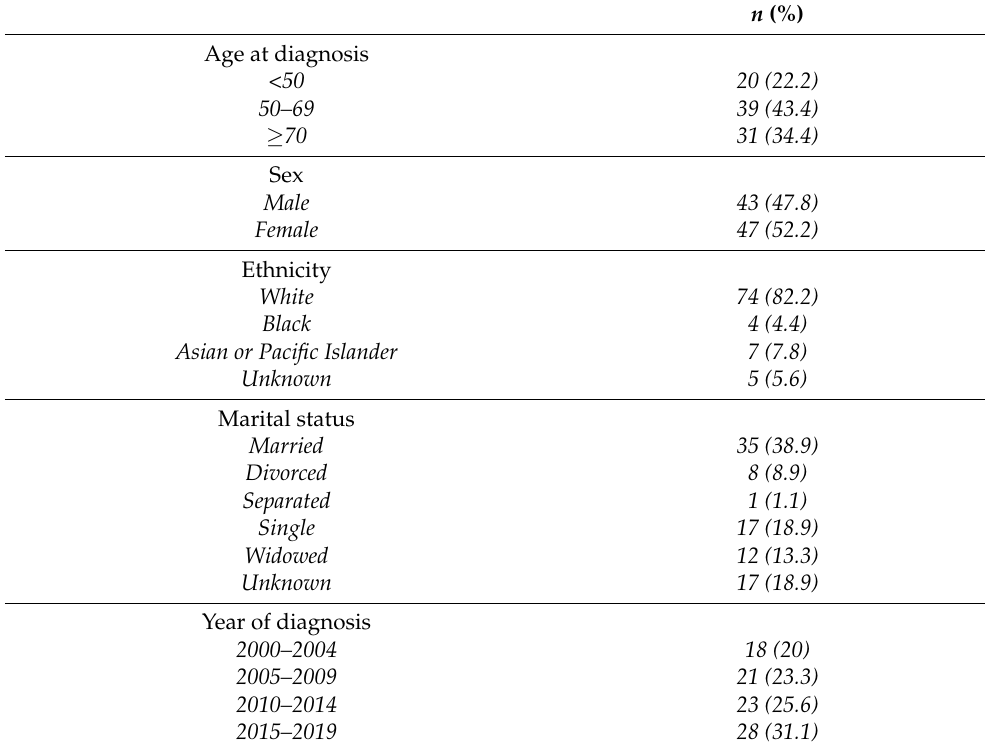
Table 1. Demographic, clinicopathological, and treatment characteristics of spiradenocarcinoma